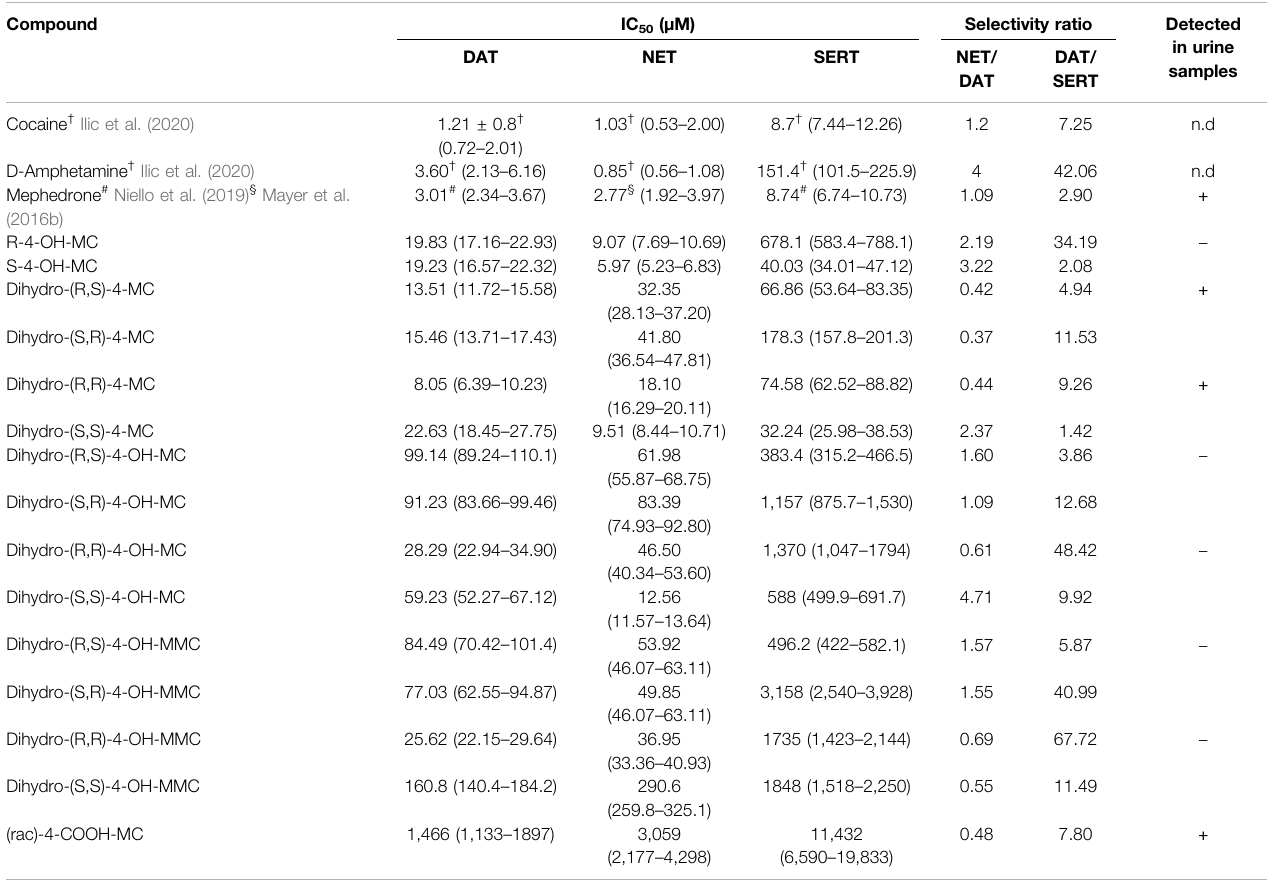
TABLE 1 | Effect of tested mephedrone metabolites on monoamine transporter mediated uptake. IC 50 values are represented in μ M as the mean (95% con fi dence interval) obtainedfromnon-linearregression.NET/DATratio (cid:2) (DATIC 50 )/(NETIC 50 ).Values > 1indicategreaterNETselectivity.DAT/SERTratio (cid:2) (SERTIC 50 )/(DATIC 50 ).Values > 1 indicate greater DAT selectivity. In the right column is highlighted if the metabolites were detected (+), not detected ( − ) or not determined (n.d.) in the urine samples analyzed. Only syn- and anti- con fi gurations could be